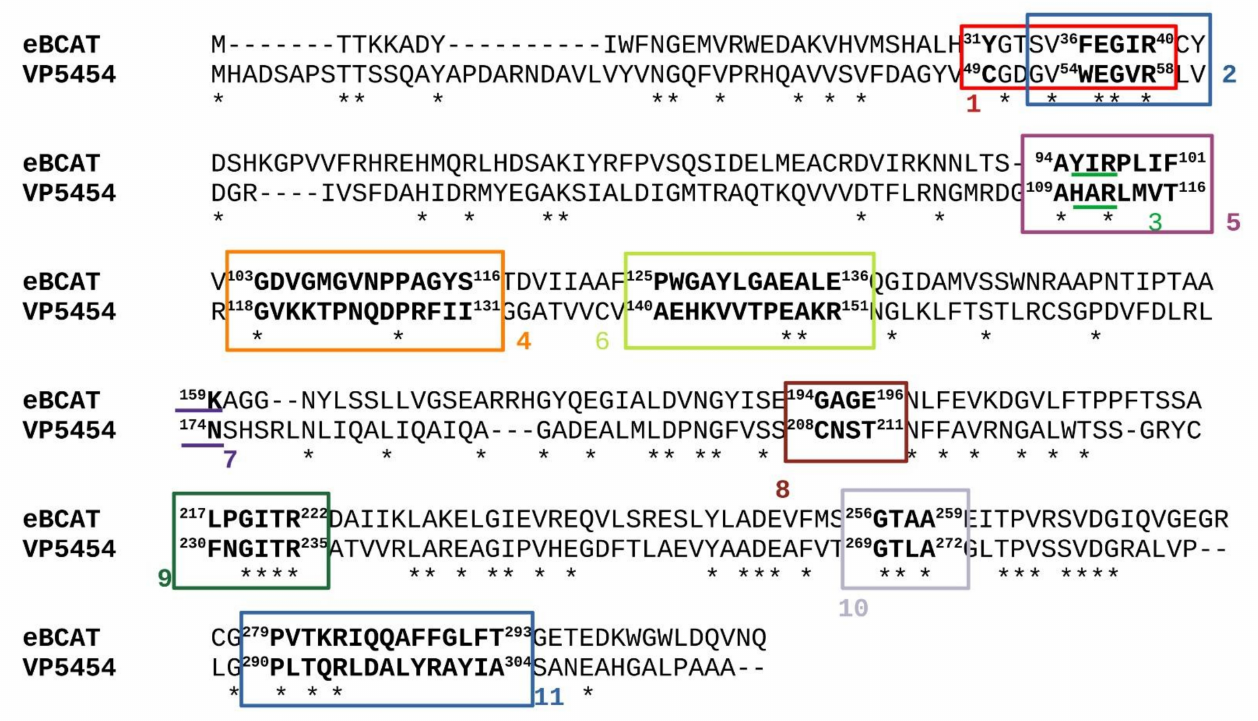
Figure 3. Amino acid alignment between VP5454 and eBCAT. Canonical TA motifs are highlighted, and conserved amino acids are marked with asterisk. Digital labels are following: